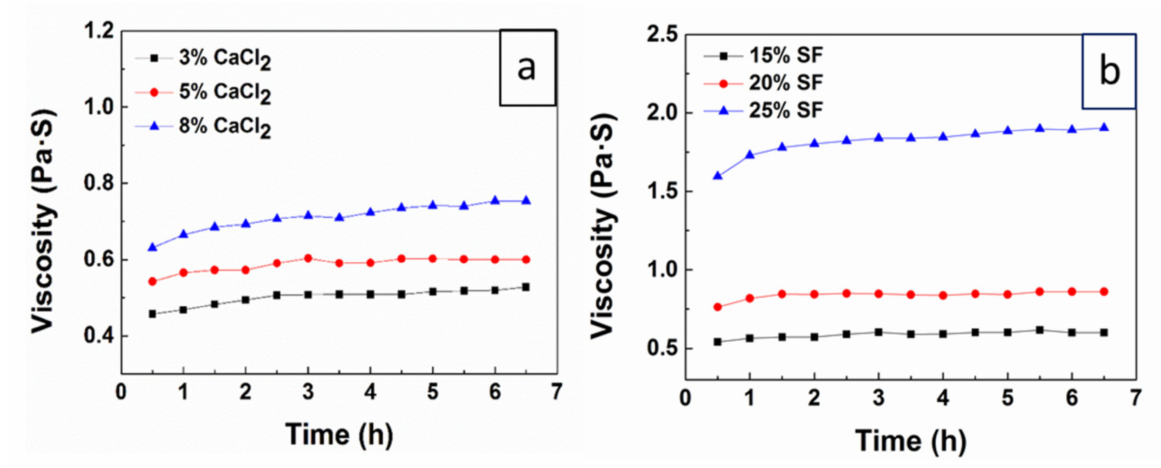
Figure 1. The viscosity changes of different silk fibroin (SF)/CaCl 2 /formic acid (FA) solutions ( a ) the content of CaCl 2 in CaCl 2 /FA solvent was 3, 5, and 8 ( w/v ) %, respectively, when SF concentration was 15 ( w/v ) %. ( b ) The concentration of SF was 15, 20, and 25 ( w/v ) %, respectively, when the content of CaCl 2 was 5 ( w/v )